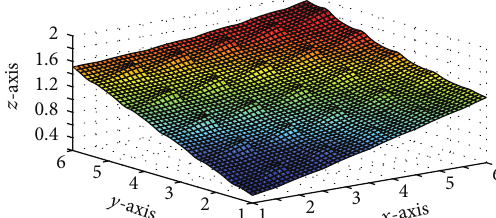
Figure 5: 𝐶 1 rational trigonometric bicubic function with 𝛼 𝑖,𝑗 = 14 , = 15 , 𝛾 = 6 , 𝛿 = 7 , 𝛼 = 8 , 𝛽 = 8 , 𝛾 = 4 , 𝛿 = 𝛽 𝑖,𝑗 𝑖,𝑗 𝑖,𝑗 𝑖,𝑗+1 𝑖,𝑗+1 𝑖,𝑗+1 𝑖,𝑗+1 9 , ̂𝛼 = 6 , ̂ 𝛽 = 5 , ̂𝛾 = 4 , ̂ 𝛿 = 8 , ̂𝛼 = 15 , ̂ 𝛽 = 2 , ̂𝛾 = 𝑖,𝑗 𝑖,𝑗 𝑖,𝑗 𝑖,𝑗 𝑖+1,𝑗 𝑖+1,𝑗 𝑖+1,𝑗 12 , ̂ 𝛿 = 8 𝑖+1,𝑗